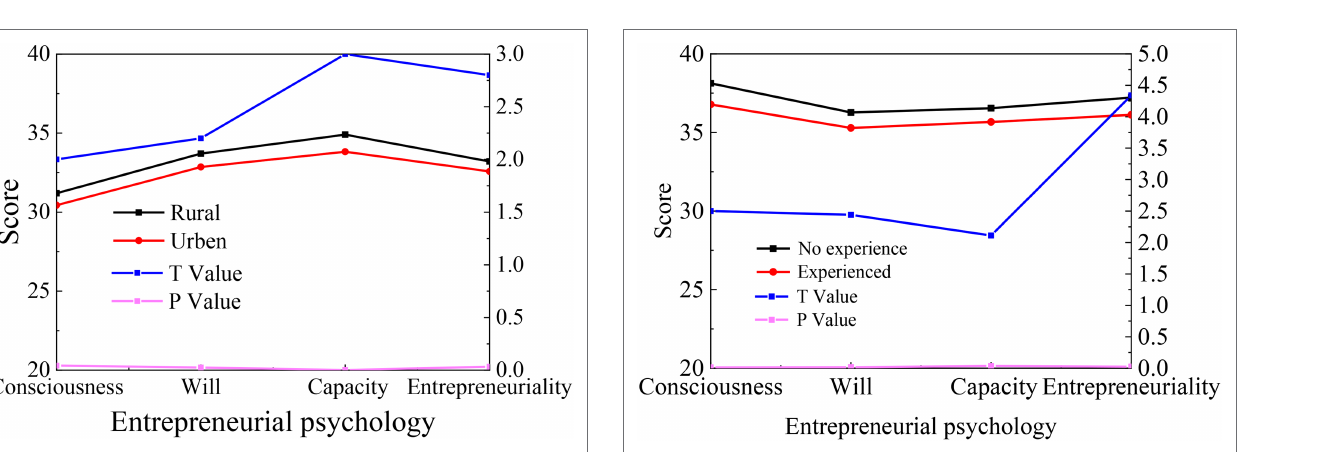
FIGURE 4 | Statistics on the differences of College Students’ entrepreneurial psychology between urban and rural household registrations.